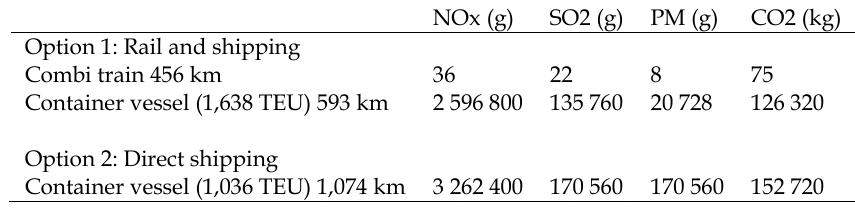
Calculated amount of emissions (in g, kg) in Option 1 and Option 2 NOx (g) SO2 (g) PM (g) CO2 (kg) Option 1: Rail and shipping Combi train 456